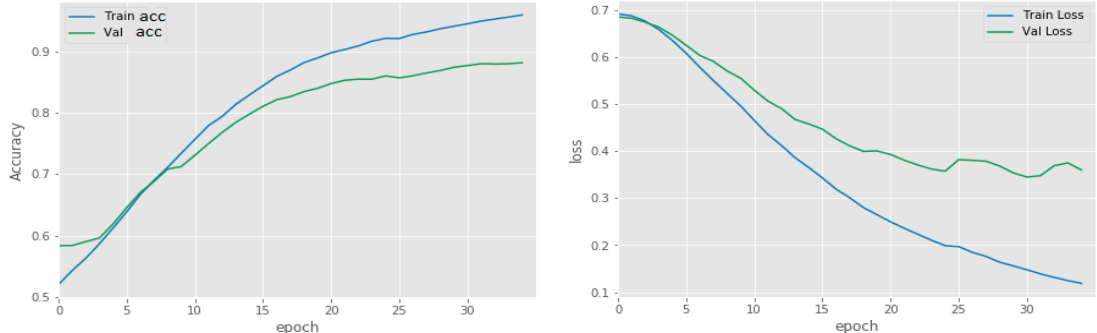
Figure 7. Accuracy and loss of the training and validation subsets as a function of number of epochs. Table 4. Tumor binary classification: precision, recall and accuracy of the training BraTS 2017 da- taset.